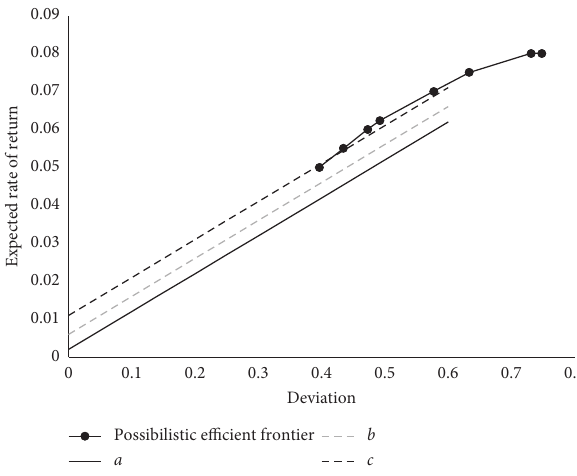
Figure 3: Some possibilistic efficient portfolios with different l Table 5: Possibilistic efficient portfolios with risk-free investment for the different α values with l